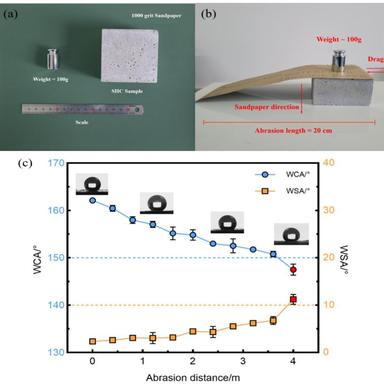
Concrete superhydrophobic coating abrasion test. (a) Materials used in the abrasion test, (b) abrasion test schematic and (c) superhydrophobic concrete abrasion CA/SA graph.